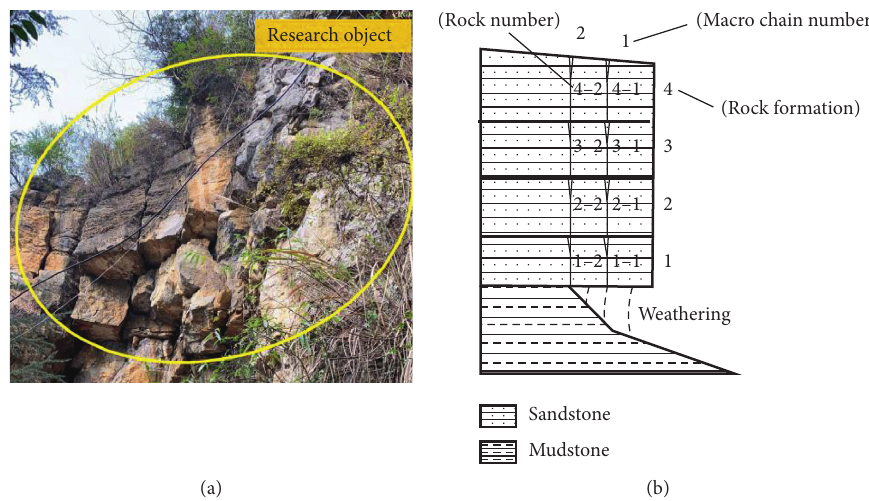
Figure 1: The real scene of the slope. (a) Duwen Highway Slope. (b) Rock slope model.